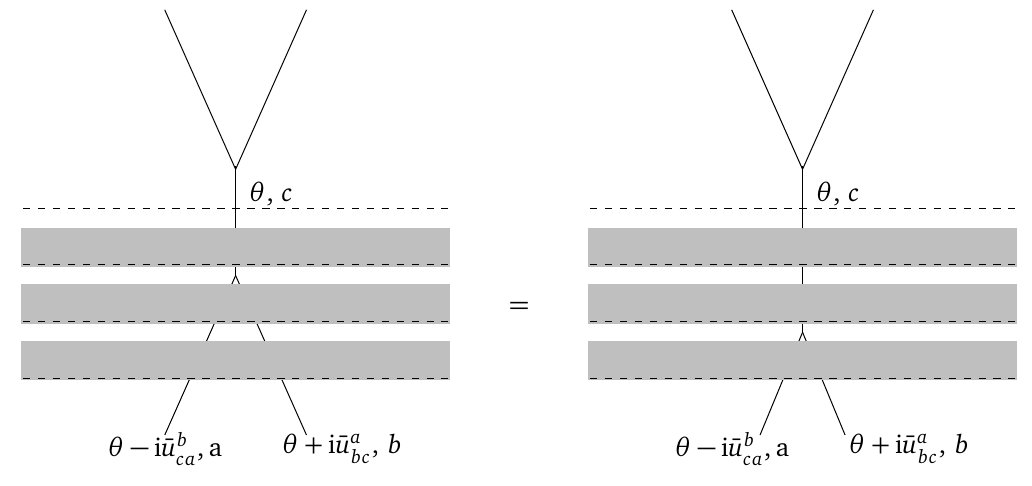
Figure 10: Floquet bound-state bootstrap